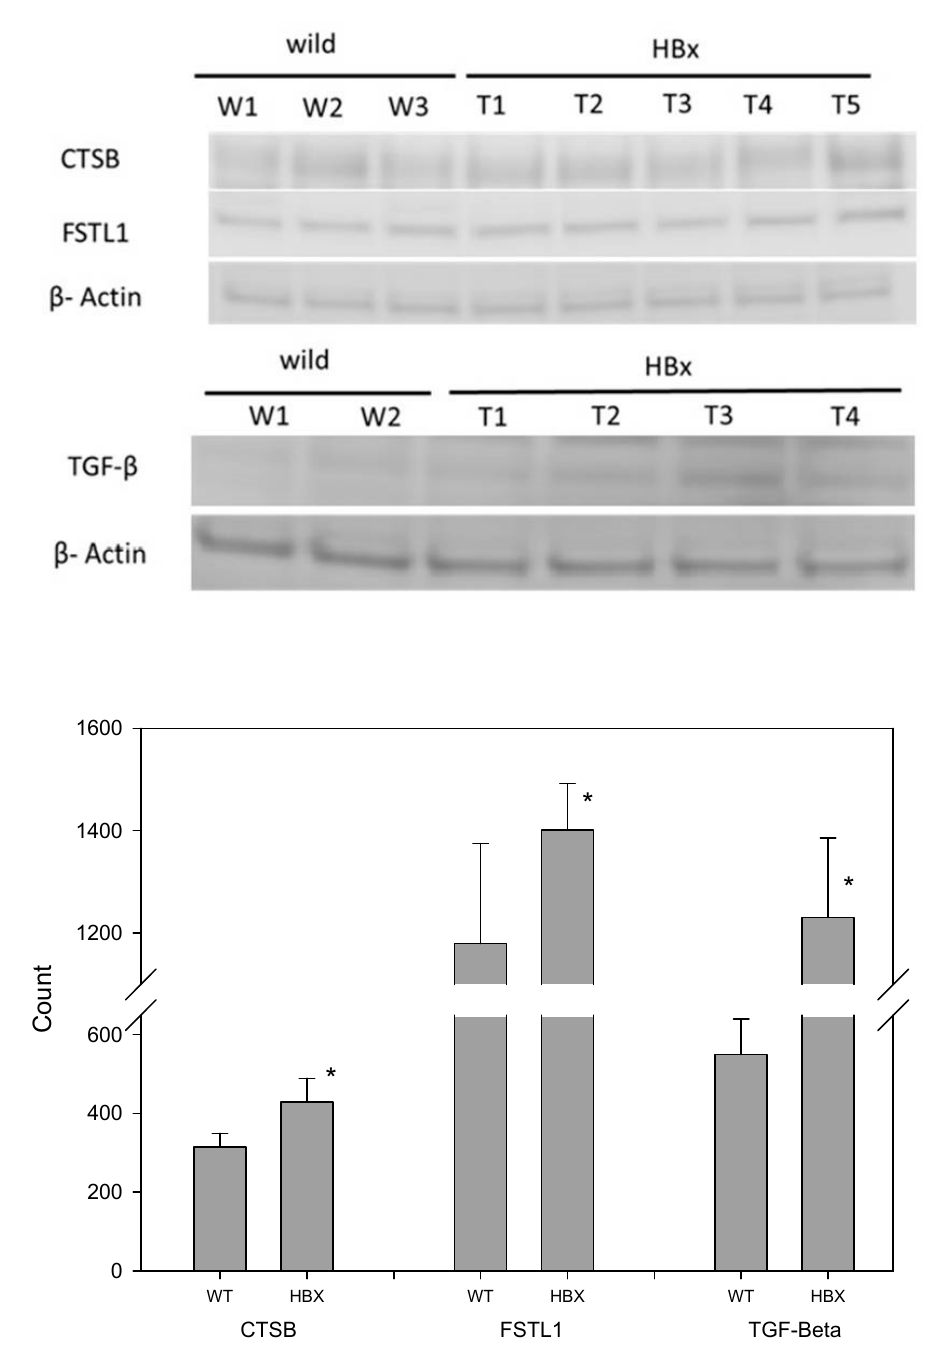
Figure 6. Western blotting of mouse liver samples from WT and HBx groups. Samples were stained with antibodies of CTSB, FSTL1, TGF- β and β -actin (N = 8, * p < 0.05). The differential protein expressions of CSTB, FSTL1 and TGFb were detected by three methods.